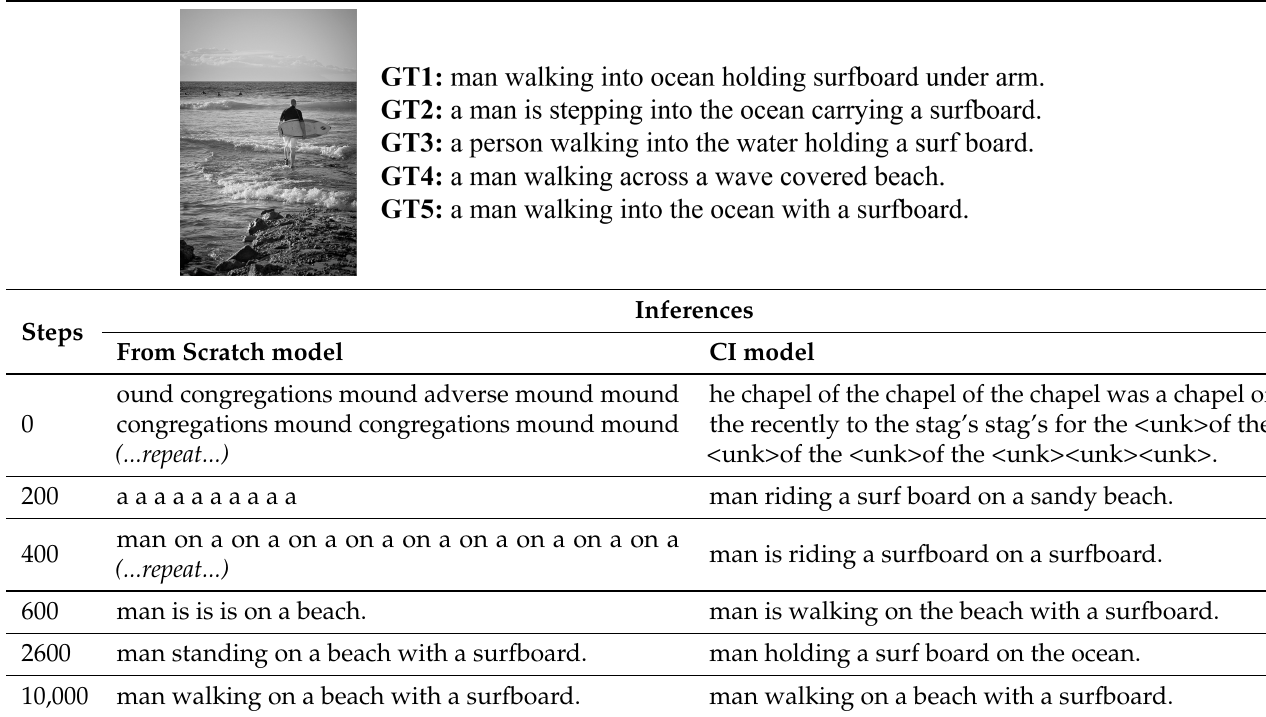
Table 5. Qualitative analysis of the vanilla image captioning model. The From Scratch model and the CI model were trained while performing inference on the test data image. 1 batch is 1 step, and the batch size is set to 20. 20,705 steps is 1 epoch. (...repeat...) means that the previous word is repeated until it reaches the maximum length (180